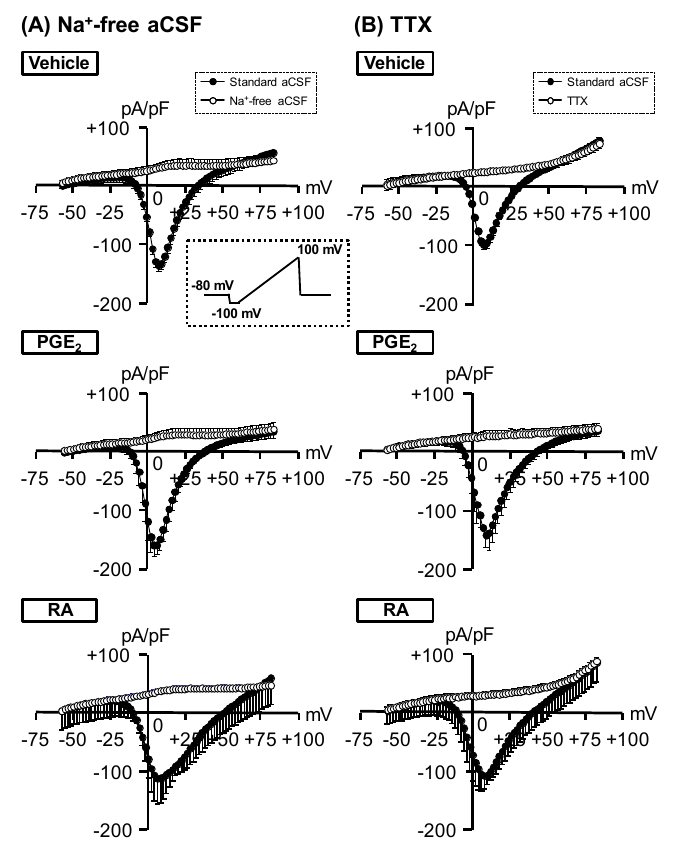
Figure 5. The effect of Na + -free artificial cerebrospinal fluid (aCSF) or tetrodotoxin (TTX) perfusion on voltage-dependent inward current. Undifferentiated NSC-34 cells were treated with a vehicle (EtOH), 30 μ M PGE 2 for 2 days, or 10 μ M RA for 7 days. Ramp currents were recorded by voltage pulses of 100 ms from –100 mV to +100 mV (insert panel). Baseline was subtracted by fitting the linear portion between − 100 mV and − 60 mV to zero. Graphs show the current–voltage relationship of the ramp currents with or without Na + -free aCSF ( A ) and 1 μ M TTX ( B ) in each treatment group. Each value represents the mean ± SD ( n = 18).